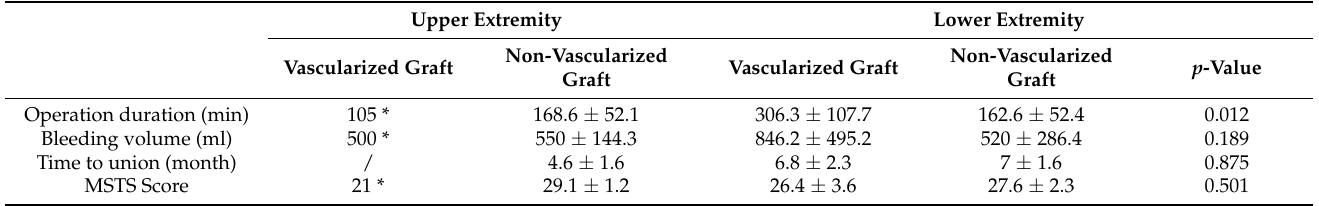
Table 4. Results According to the Management of the Fibular Graft and Comparison of the Lower Extremity